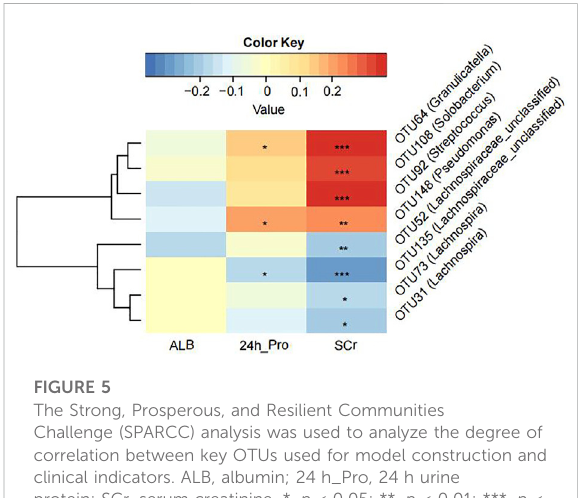
FIGURE 5 The Strong, Prosperous, and Resilient Communities Challenge (SPARCC) analysis was used to analyze the degree of correlation between key OTUs used for model construction and clinical indicators. ALB, albumin; 24 h_Pro, 24 h urine protein; SCr, serum creatinine. *, p < 0.05; **, p < 0.01; ***, p <